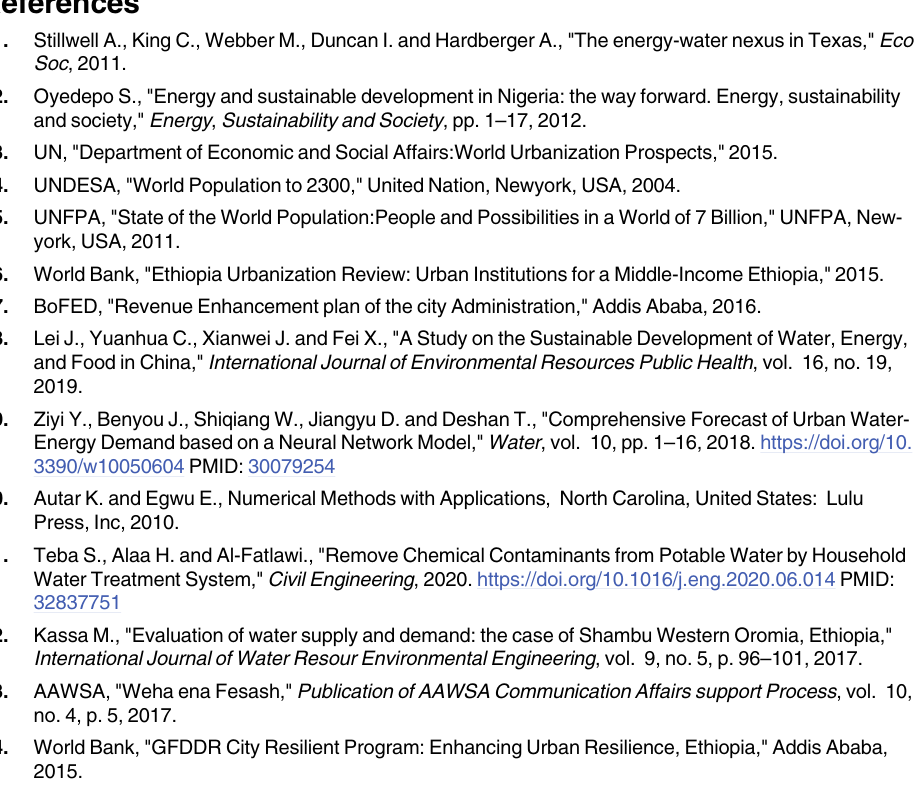
S3 Table. EEU data source, electric energy consumption by sectors from 2015 to